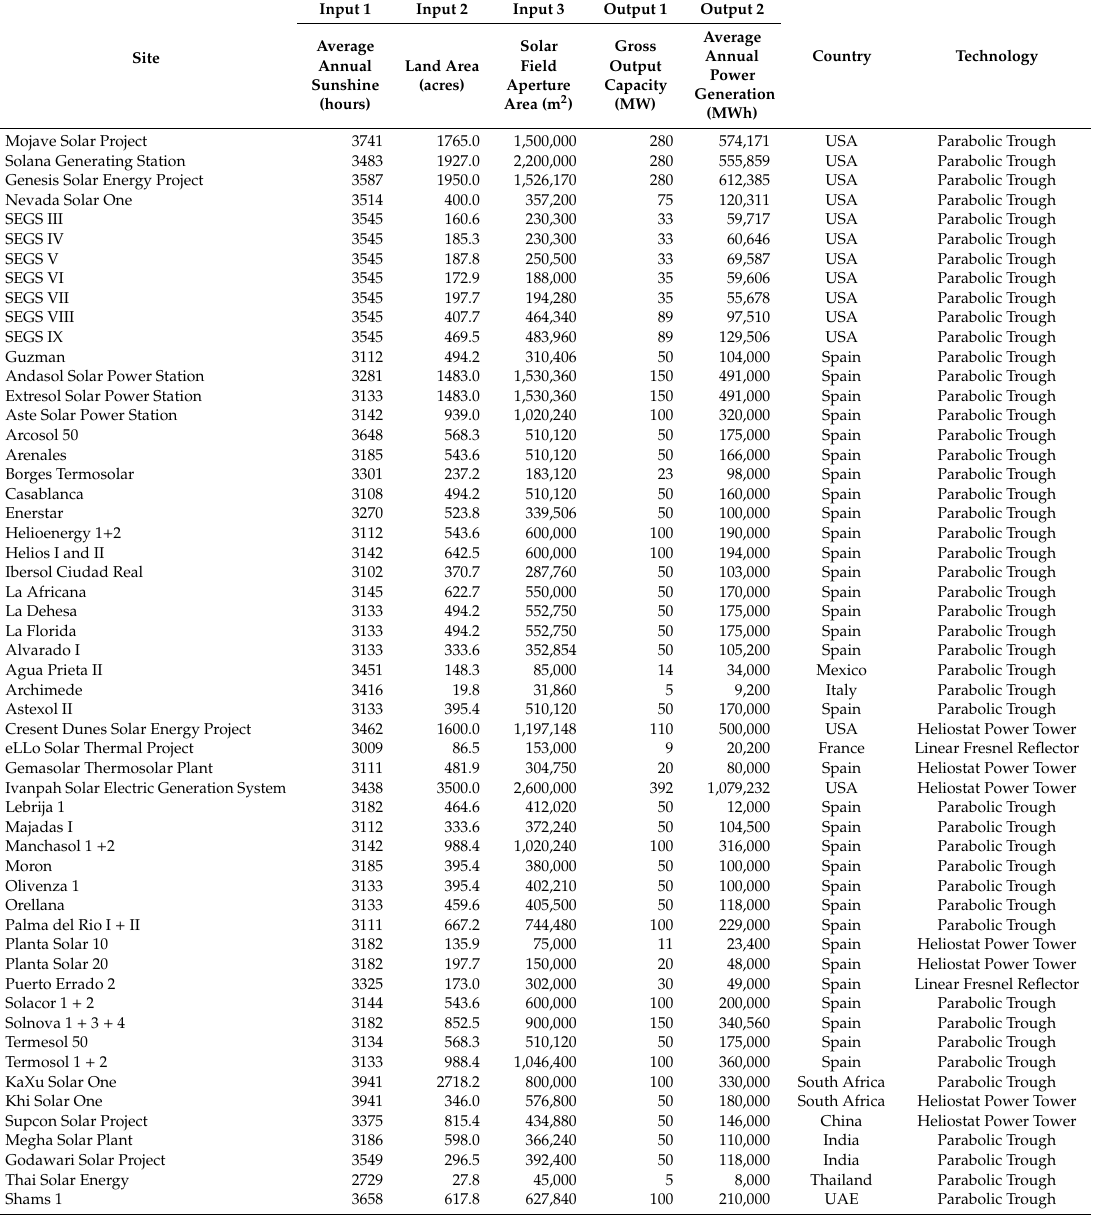
Table 3. Data on solar thermal power